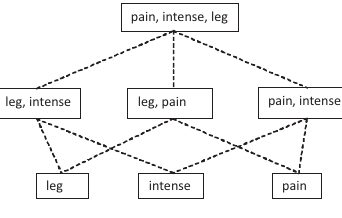
Figure 1: AP-Set